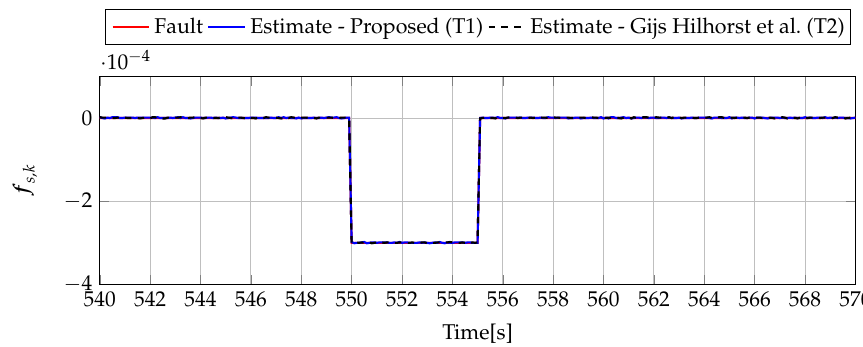
Figure 18. Fault f (red line) and fault estimate obtained with Theorem 1 (T1) and Theorem 2 (T2) s , k based on [39] for FS2 (for t = 540, . . . ,570 [s]) as well as the response for disturbance signal w 1, k .